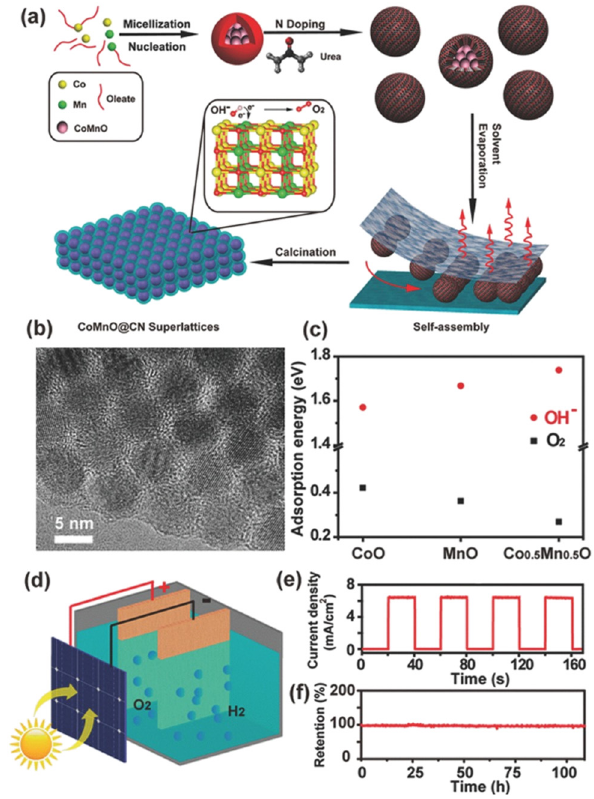
Figure 9: ( a ) Diagram of the CoMnO@CN super lattices formation. ( b ) TEM image of a CoMnO@CN super lattice. ( c ) Determined adsorp - tion energies of OH − ( red dots ) as well as O 2 ( black dots ) on CoO, MnO, and Co 0.5 Mn 0.5 O ( 001 ) surfaces. ( d ) Illustration of the solar water - splitting battery without utilizing current, applying a commercial planar Si solar battery. ( e ) Chronoamperometry analysis of the solar water - splitting battery under AM 1.5G arti fi cial sunlight. ( f ) Long - lasting strength of that solar battery under regular sunlight for ∼